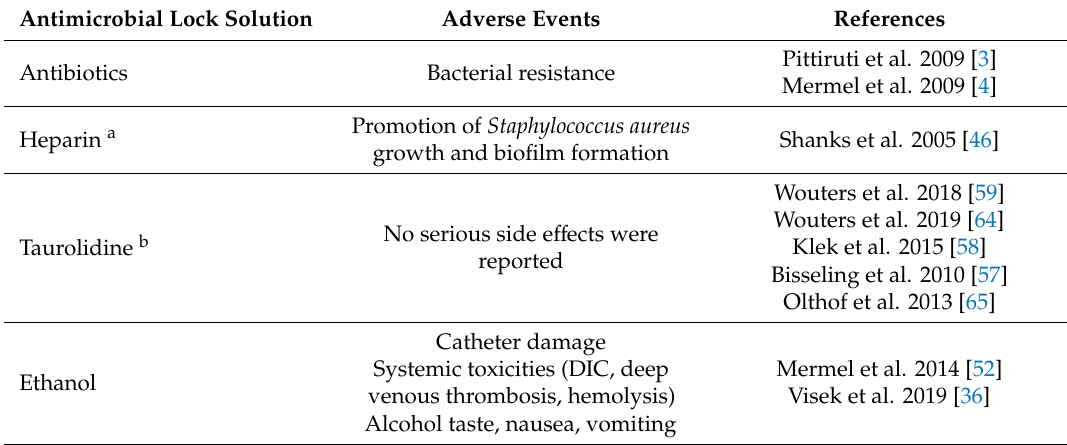
Table 3. Adverse e ff ects associated with long-term administration of antimicrobial lock solutions. Antimicrobial Lock Solution Adverse